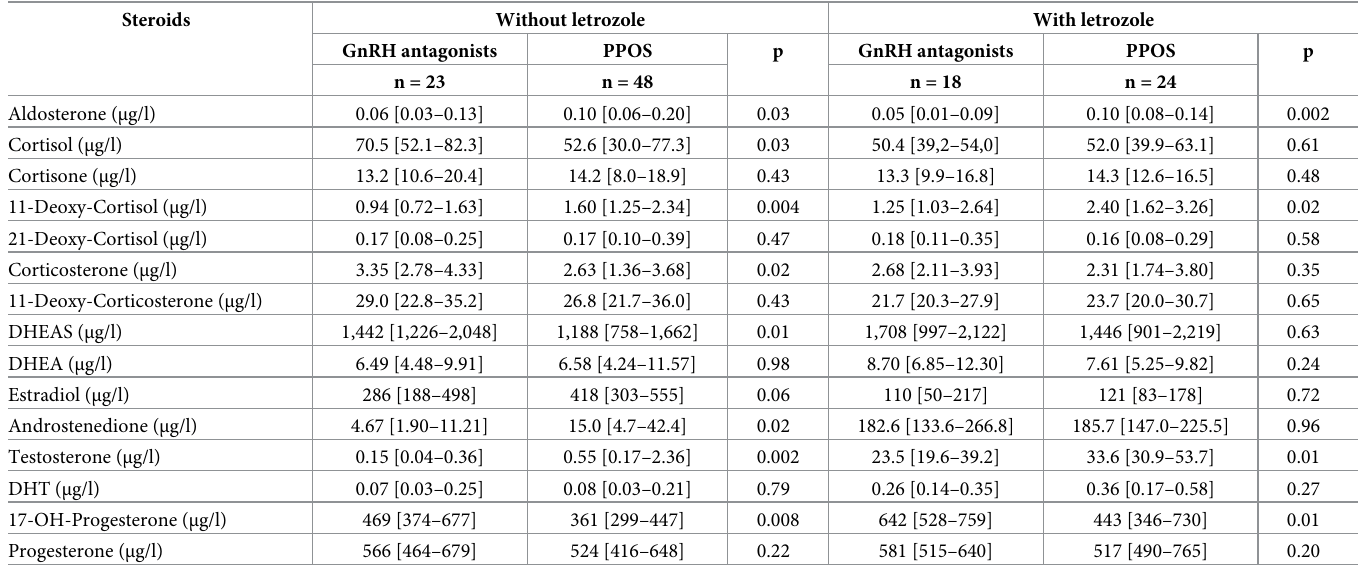
Table 3. follicular fluid steroids concentration in the two study periods, presented separately according to the concomitant assumption of letrozole. Steroids Without letrozole With